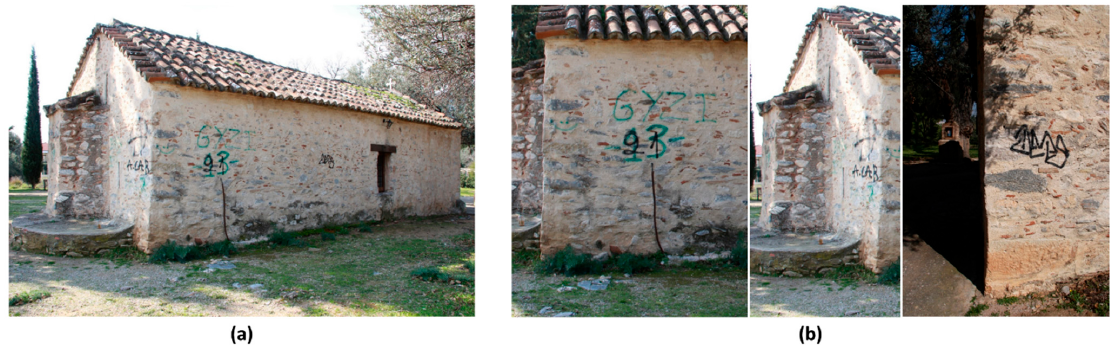
Figure 8. ( a ) The Church of Agios Nikolaos in Kantza, Greece, the historical structure used in this case study; and ( b ) samples of existing graffiti markings present.